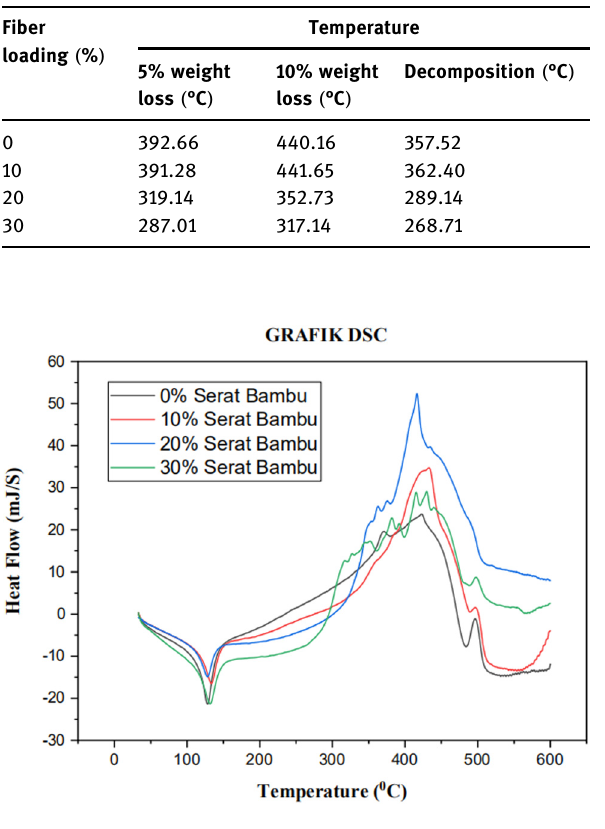
Figure 7: Curve of DSC.